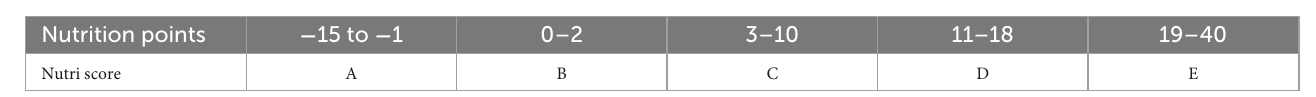
TABLE 2 Overview of nutri score categories and related to nutrition points for solid and liquid